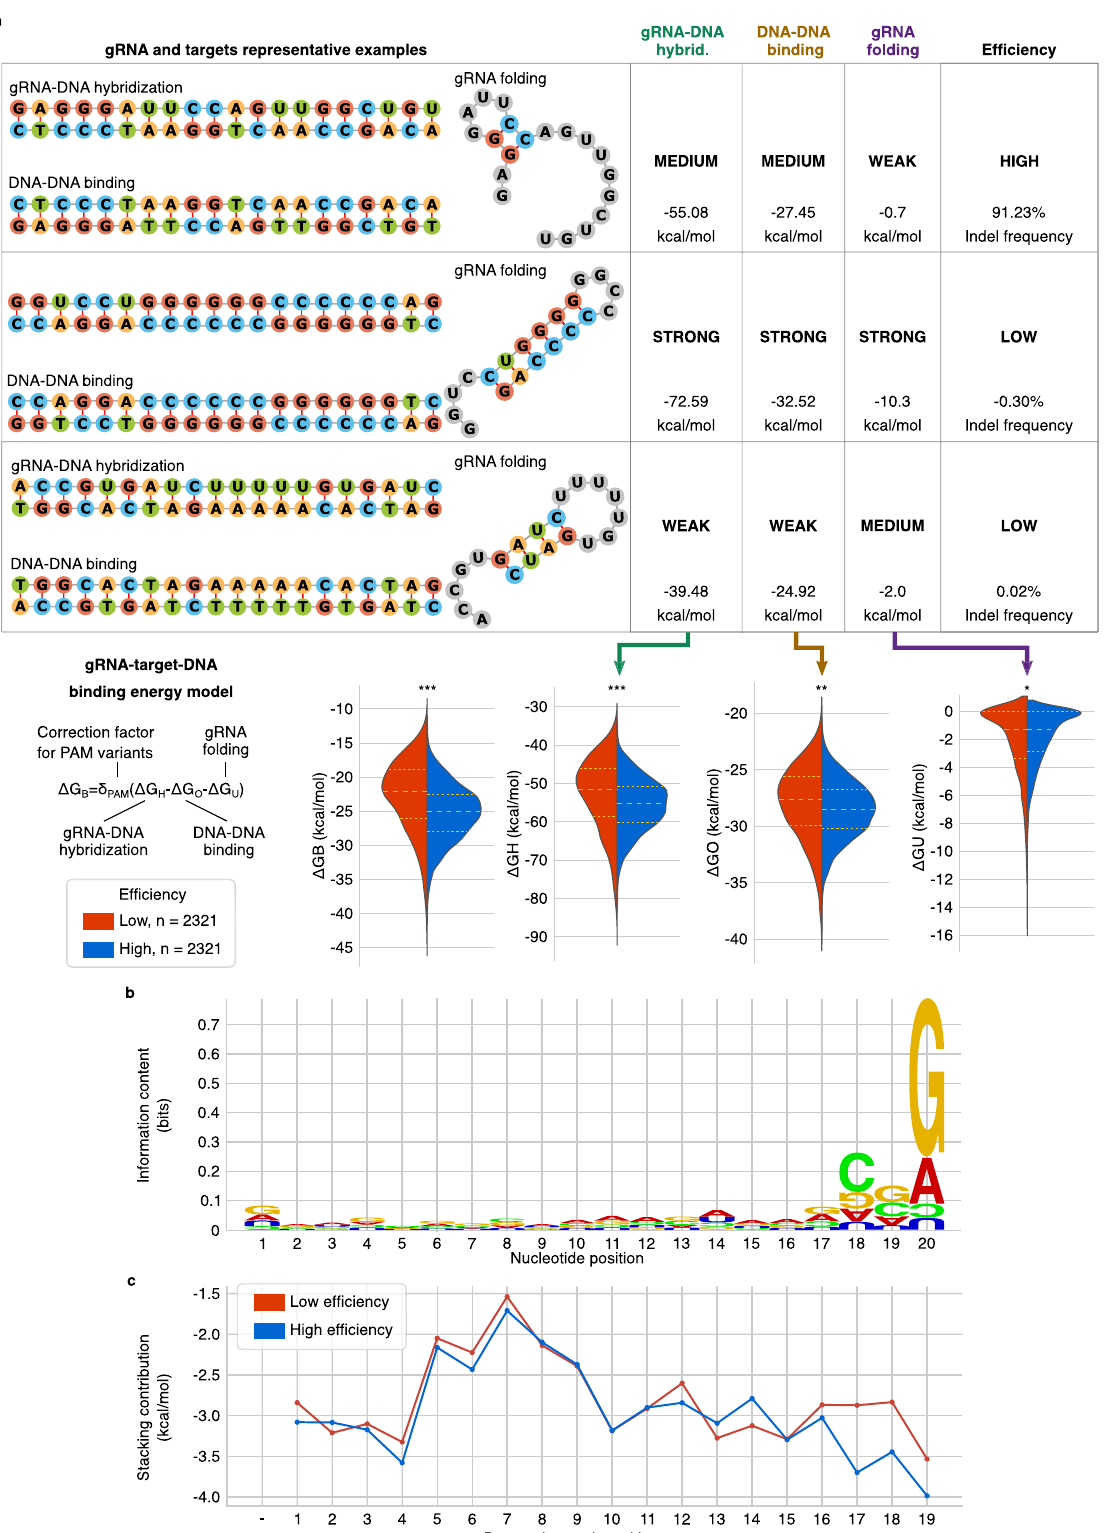
transcription termination by polymerase III 27 . Considering that stacking base pairs containing uracil present the lowest binding free energy change bene fi t (Supplementary Table 6) an additional explanation for this negative effect is possibly the poor hybridisation stability of U-rich gRNA seeds. Supporting this, the presence of up to 2 Us at the gRNA 3 ′ seed end,